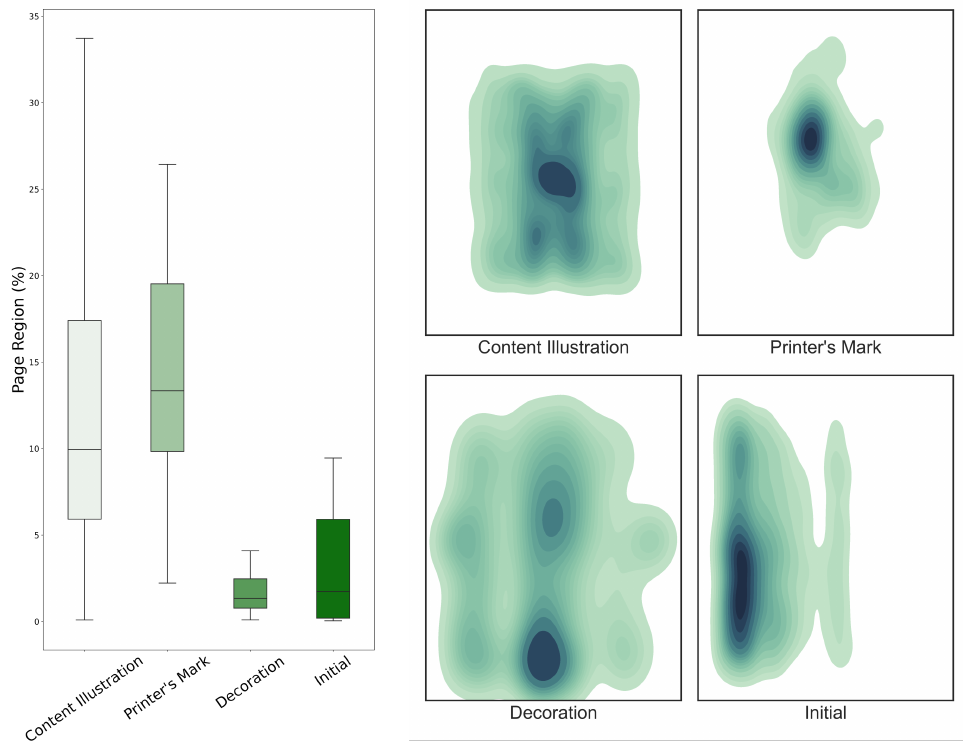
Figure 2. Distribution of visual element classes by page size percentage (90% interquartile range) and bounding box centroid